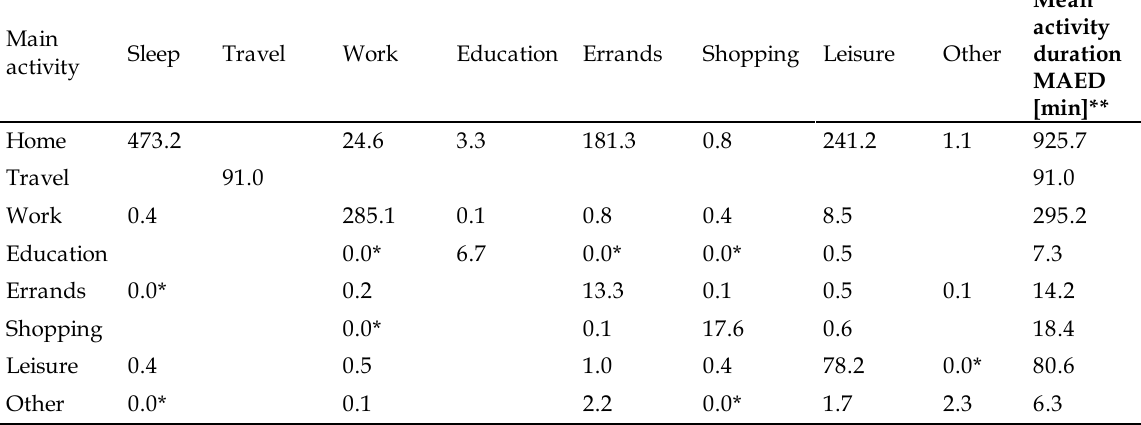
Table 5. Activity duration per detailed and main activity type (matched sample, persons with two or more